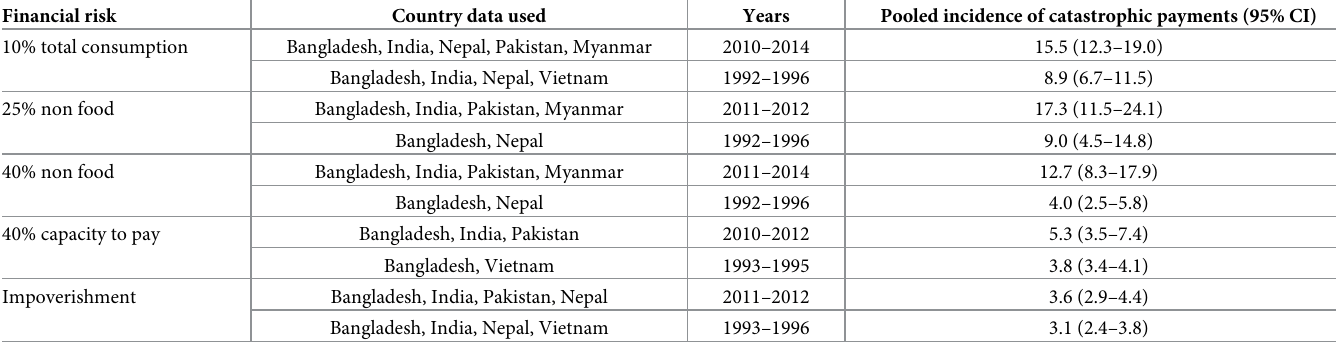
Table 1. Pooled prior for household level catastrophic expenditure and impoverishment. Financial